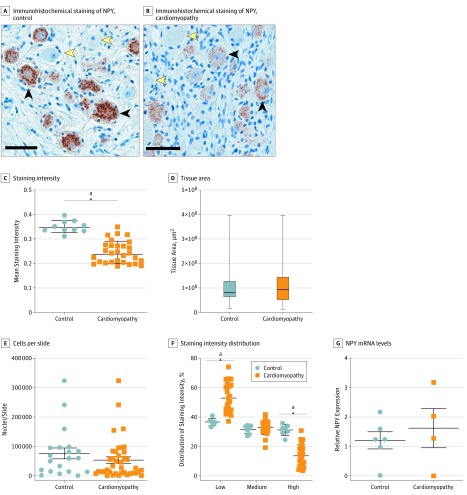
Neuropeptide Y (NPY) Content in Human Stellate GangliaImmunohistochemical staining of NPY in stellate ganglia from control patients (organ donor) and patients with cardiomyopathy shows reduced NPY immunoreactivity (A) and an overall decrease in staining intensity, measured as optical density (B). This difference was not associated with tissue area compared (C) or number of cells (neurons and glia) per slide (D). Mean staining intensity was decreased in patients with cardiomyopathy (E). Quantitative polymerase chain reaction for NPY mRNA levels (normalized to glyceraldehyde 3-phosphate dehydrogenase) showed no change in NPY messenger RNA (mRNA) in patients with cardiomyopathy compared with controls (F).aP < .001. Scale bar: 50 μm.